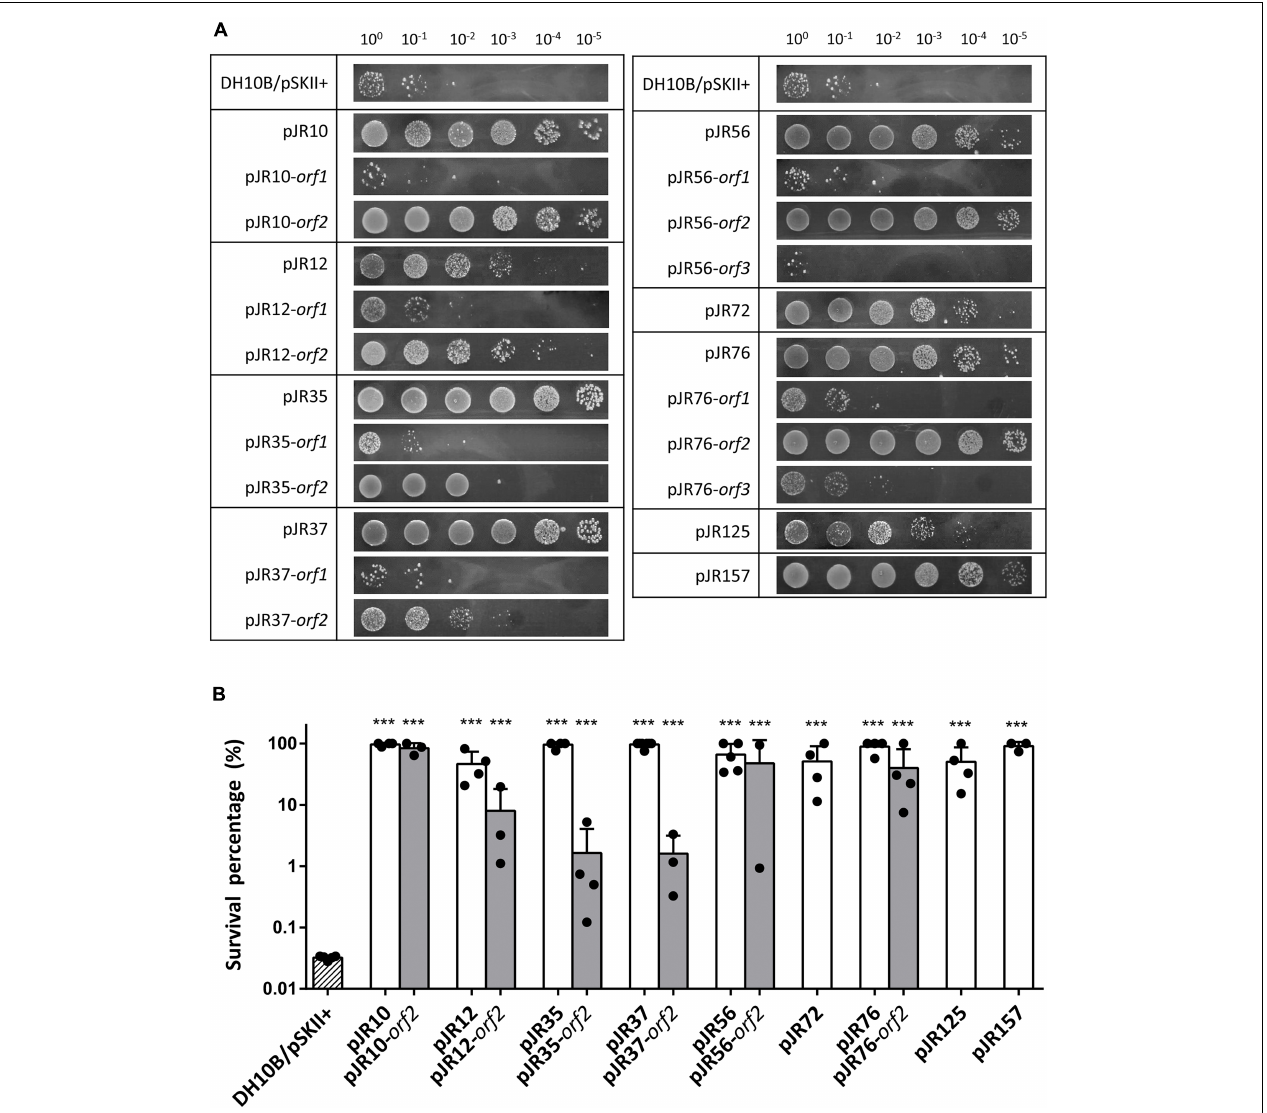
FIGURE 1 | Drop assays (A) and survival percentage (B) of the nine complete clones and individual predicted ORFs involved in perchlorate-resistance. Cultures were grown overnight at 37 ◦ C, drops of 10-fold serial dilutions were plated on LB-Ap containing 125 mM of sodium perchlorate and plates were incubated for 48 h at 37 ◦ C. Survival percentage was calculated as the number of CFU mL − 1 remaining after the treatment divided by the initial CFU mL − 1 . E. coli DH10B bearing empty pSKII+ (pBlueScript II SK +) vector was used as a negative control. One-way ANOVA followed by Dunnet post hoc analysis revealed the displayed significant differences against the negative control (*** p < 0.001). Data represent the mean ± S.D ( n ≥